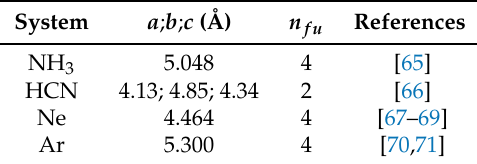
Table 1. Structural information about the bulk structures used in this study. n fu is the number of formula units per unit cell. References for the geometrical information of the respective system are provided in the last column. Please note that there was a mistake in the cell parameters of CO 2 provided in reference